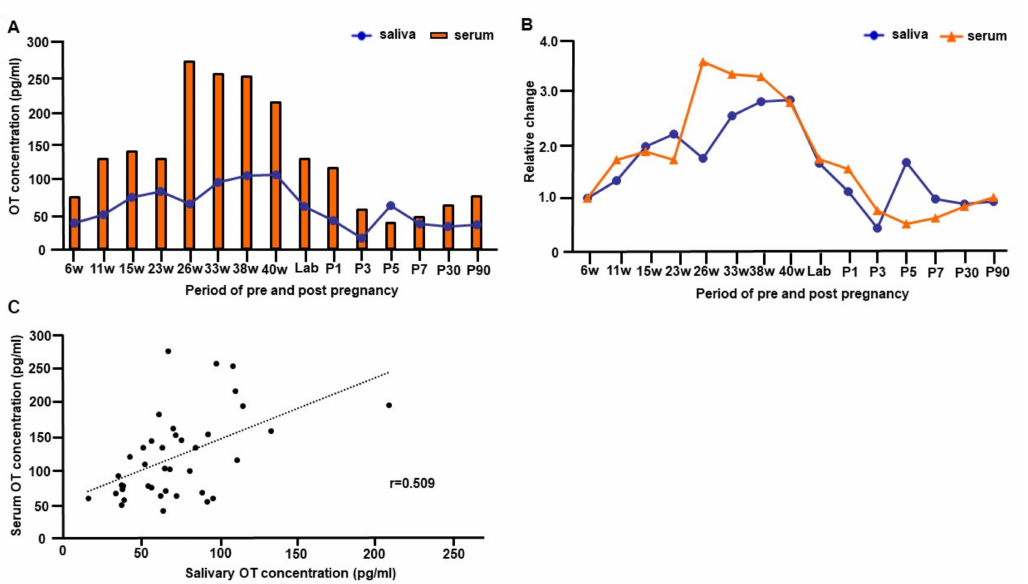
Figure 3. The trajectory of salivary and serum oxytocin (OT) concentrations from early pregnancy to 90 days postpartum of one woman. ( A ) The concentration of salivary and serum OT levels from 6 weeks gestation to 90 days postpartum. The basal OT concentration from the measurement of breastfeeding experiments was used for values of postnatal days. The value in the intermittent period of first stage labor was used for plotting the time point of labor (value at cervical opening 3). ( B ) The trajectory of relative changes of salivary and serum OT levels from 6 weeks gestation to 90 days postpartum. ( C ) Correlation between salivary and serum OT concentrations from early pregnancy to postpartum day 90. Note that OT concentrations from every time point of all postnatal breastfeeding experiments were